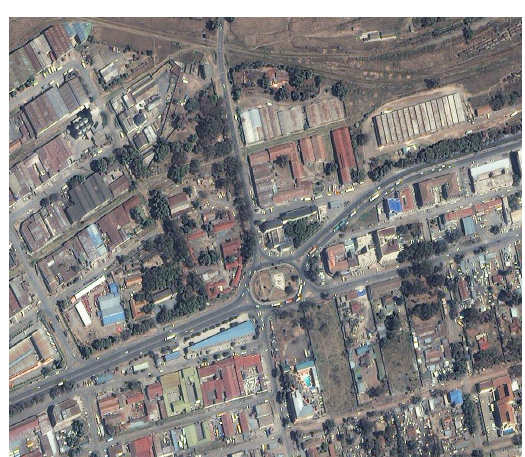
Figure 2: IKONOS 0.8m Natural Color Image of Nakuru, Kenya (taken on February 2008)